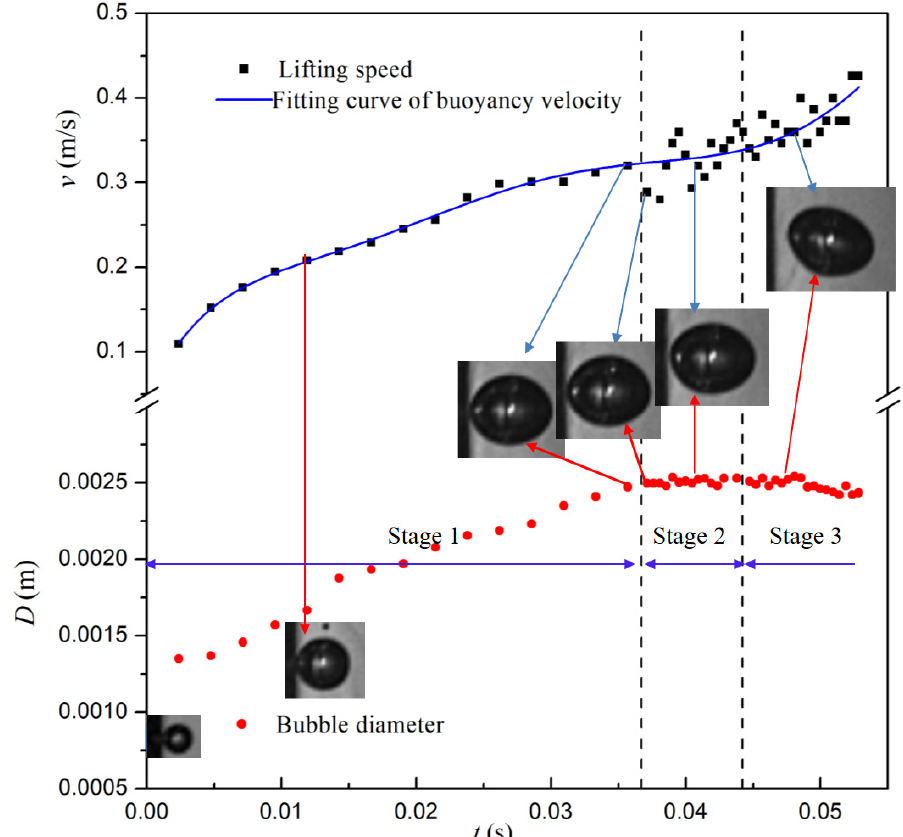
Figure 5. The independent growth process of a single bubble in open space.